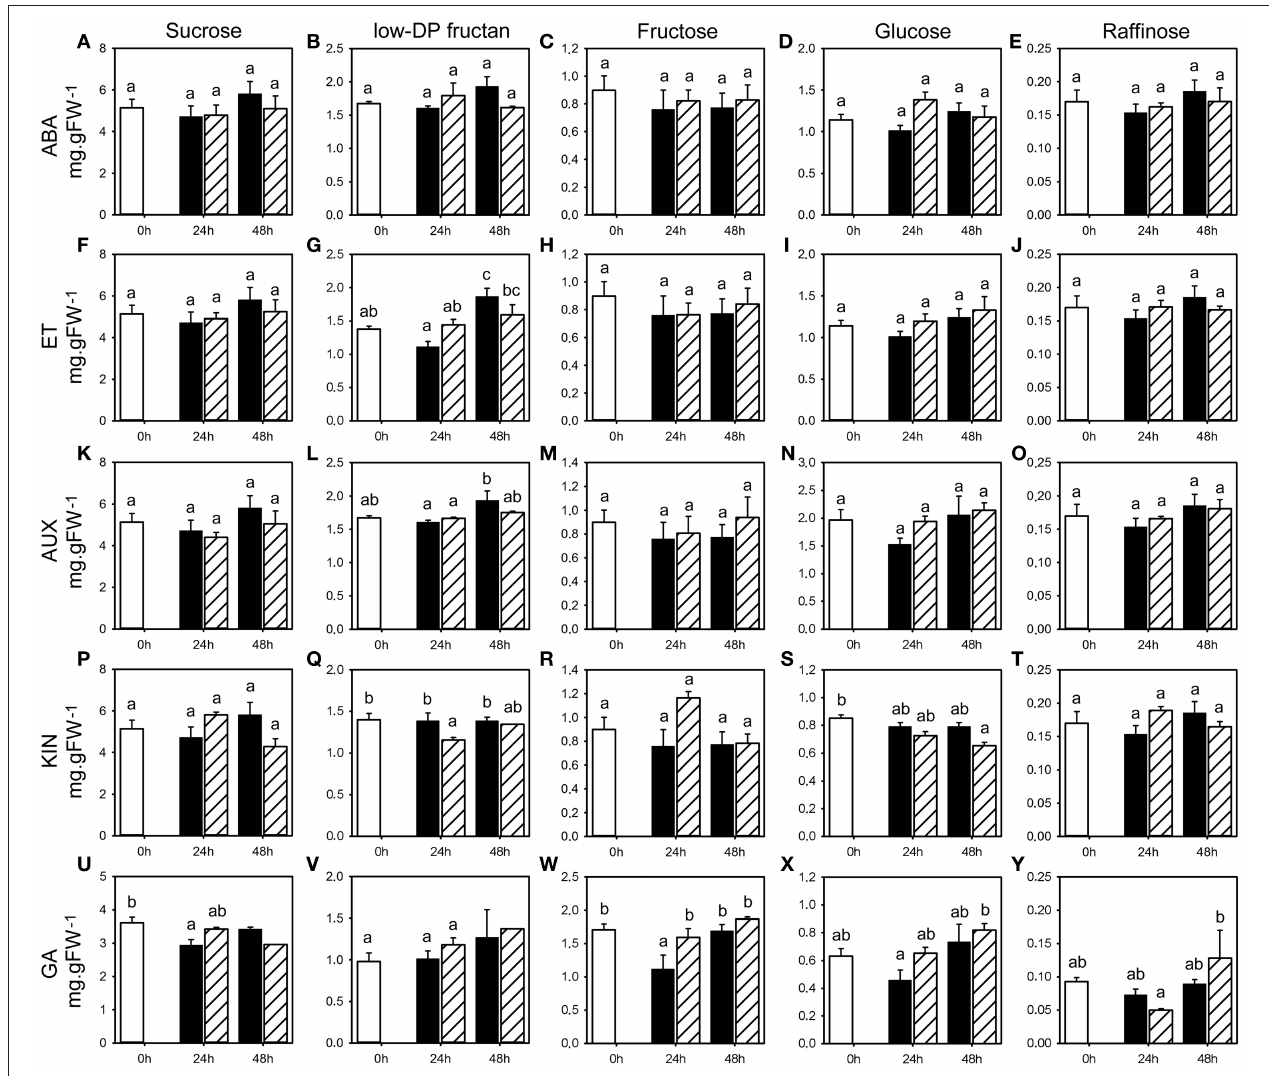
FIGURE 7 | WSC concentrations following phytohormone treatments. Concentrations of sucrose, low-DP fructans fructose, glucose, and raffinose (mg.gFW − 1 ) in the first basal cm of stubble of 4-week old perennial ryegrass seedlings 24 or 48h post ABA (A–E) , ET (F–J) , AUX (K–O) , KIN (P–T) , or GA (U–Y) treatment, compared to untreated controls (0 h). Open bars, untreated controls; closed bars, mock treatment; dashed bars, phytohormone treatment. Values represent the mean of three biological replicates ± SE (except V 48h GA: one sample). Different letters indicate statistical significance at p < 0.05 . Representative examples are shown from one of the three